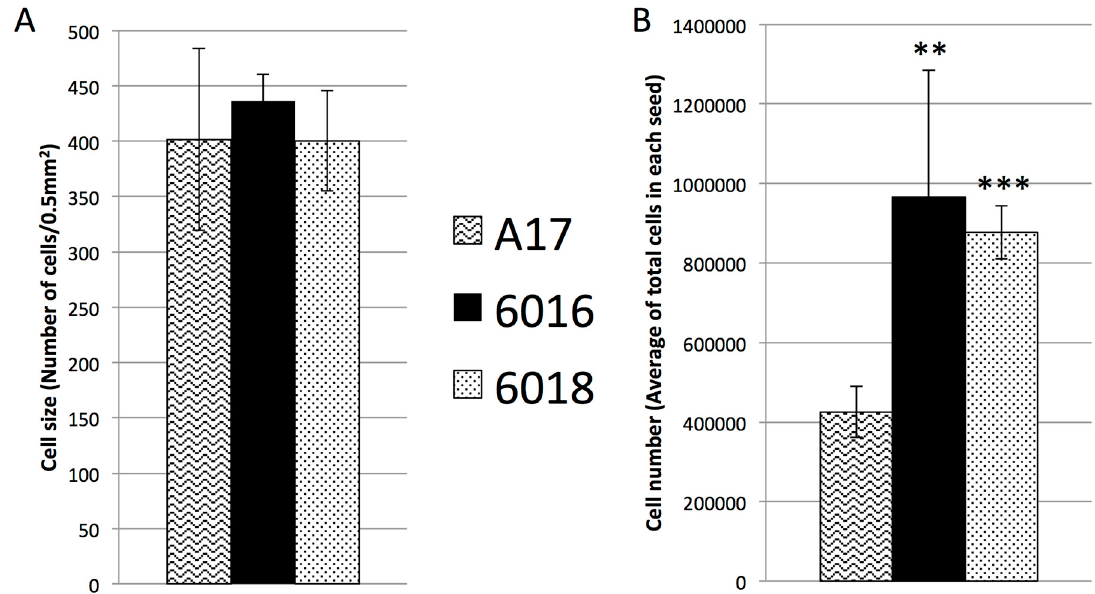
Figure 3. Cell size and cell number in mature seeds of the three accessions. ( A ) Cell size measured as number of cells counted in frozen sections of mature seeds in a specific area (0.5 mm 2 ) ( n = 6); ( B ) Average of total number of cells obtained from single mature seeds (excluding seed coat) of the three different accessions using a haemocytometer cell ( n = 16). Statistical differences resulting from t -test are indicated with **: p -value < 0.01 and ***: p -value < 0.001.